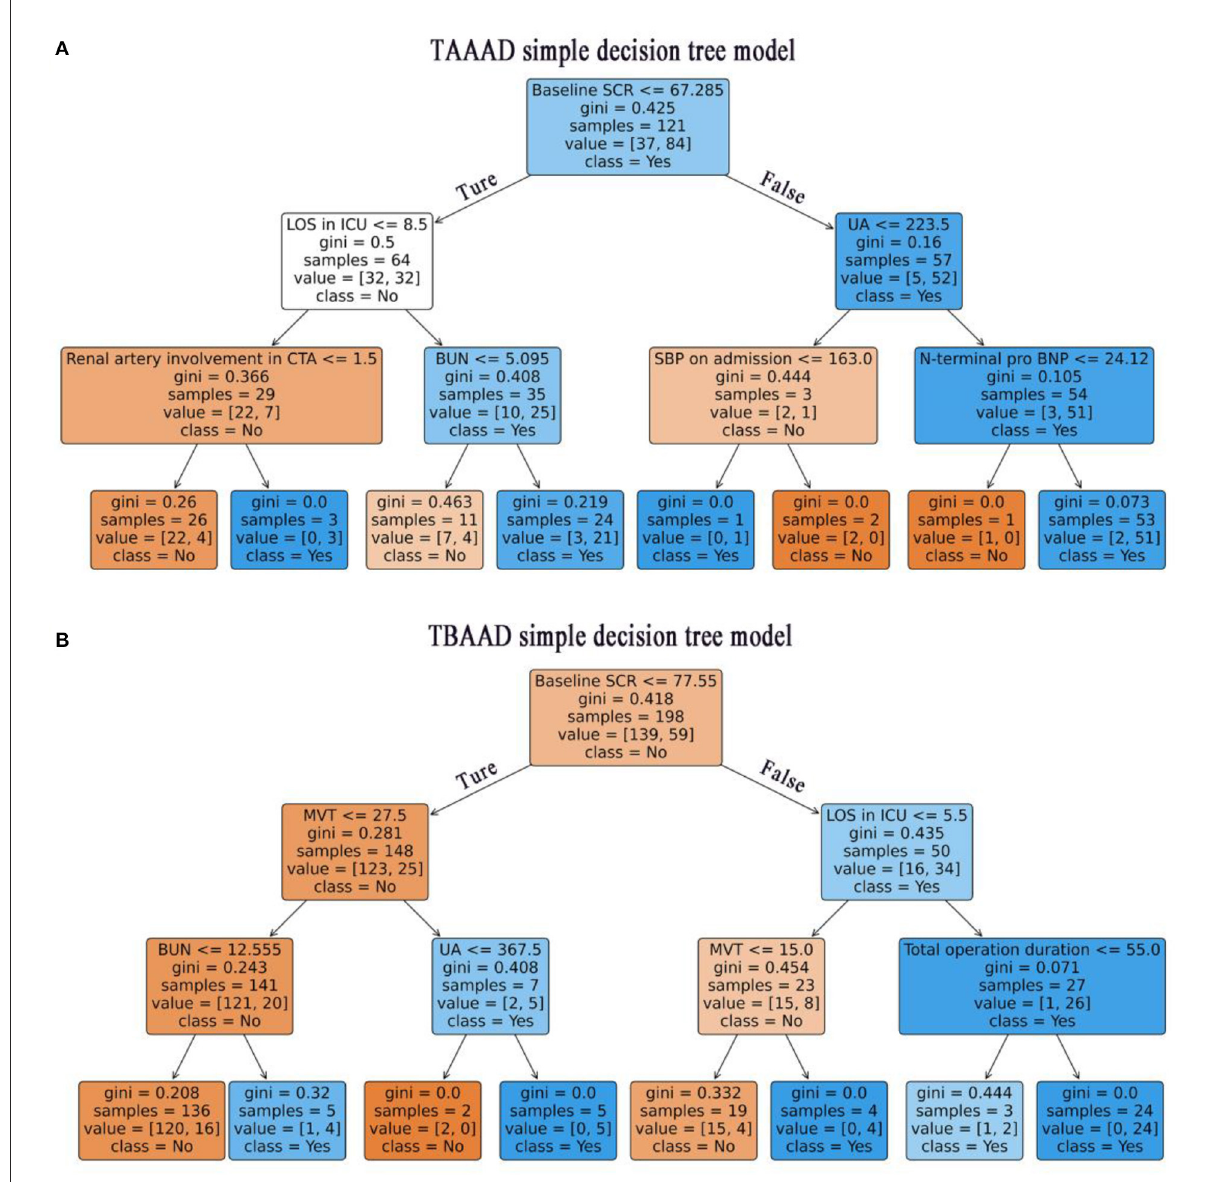
FIGURE5 Visualization of the decision tree model. Recursive determination of whether a patient has AKI, blue represents AKI and orange represents Non-AKI. Each box represents a node and the straight lines with arrows represent edges, both on the left are Ture and both on the right are False. The main contents contained in the boxes are: the features used to slice the current node; The Gini represents the possible error rate of the current node, and the smaller the Gini index in this figure, the higher the color density of the node. Value is the actual number of non-AKI and non-AKI patients contained in the current node, and class represents the patient class predicted by the current node (class = No: non AKI patients, class = Yes: AKI patients). (A) Shows the TAAAD-AKI decision tree model. (B) Shows the TBAAD-AKI decision tree model.